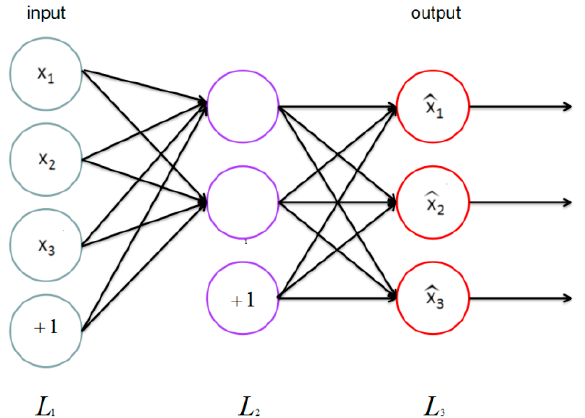
Figure 5. Sparse autoencoder.